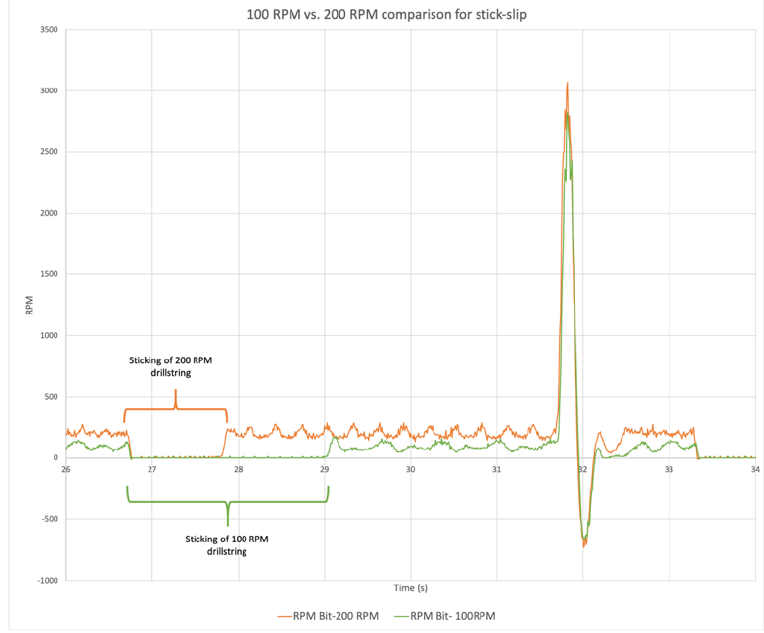
Figure 22. Comparison of 100 vs. 200 RPM string on stick-slip vibrations.